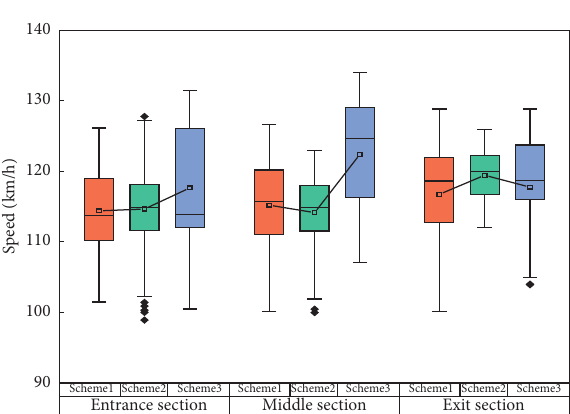
Figure 11: Speed changes in different tunnel sections for different right lateral